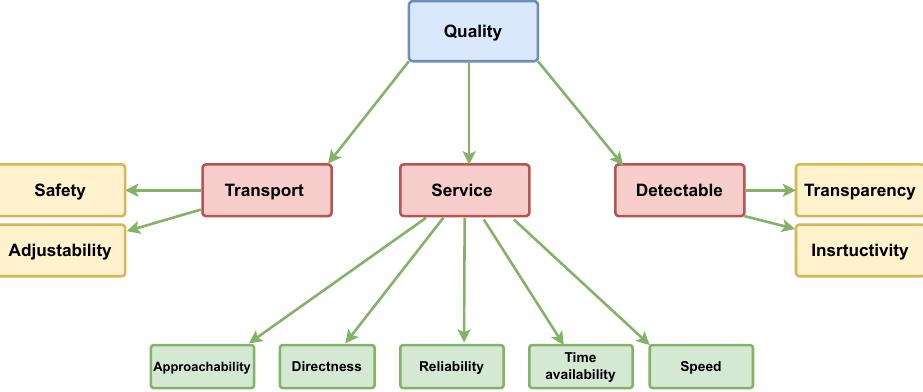
Figure 2. The hierarchical architecture of the supply quality in public transport